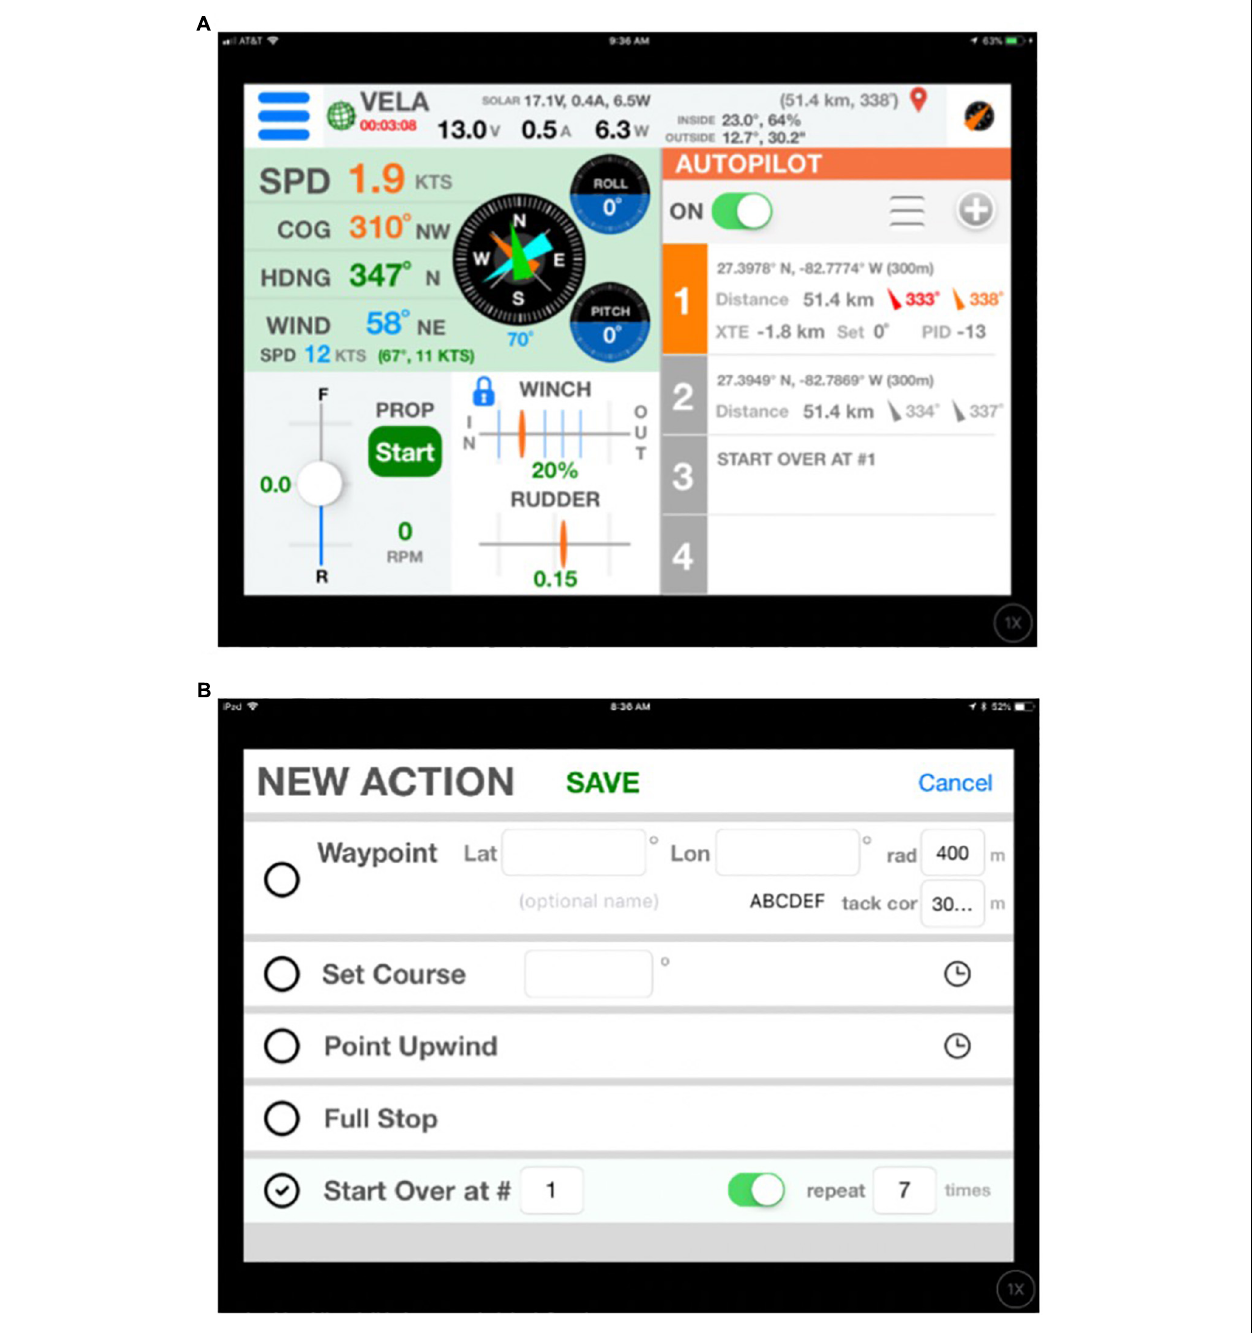
FIGURE 2 | Screenshots of the iOS control software running on an iPad, illustrating operation via Manual Control (A) or via Waypoint navigation (B)